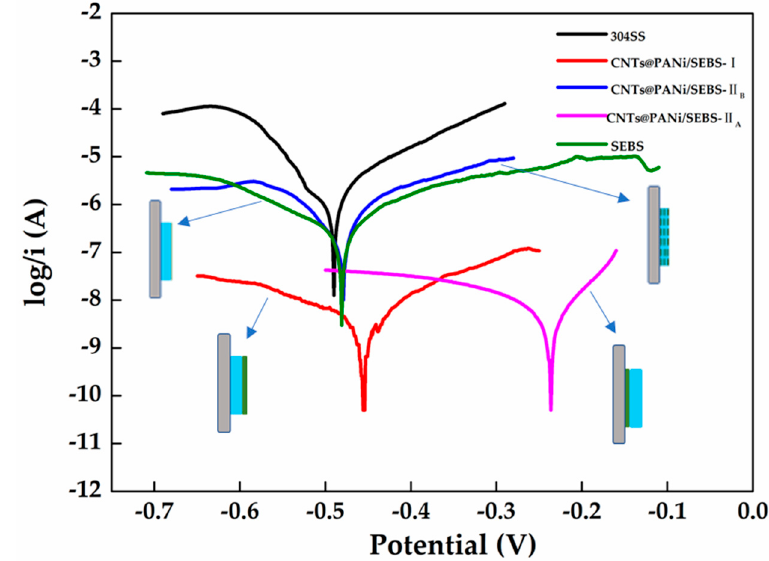
Figure 7. Tafel curves of CNTs@PANi/SEBS composite films. Table 2. Tafel polarization parameters of CNTs@PANi/SEBS composite films.